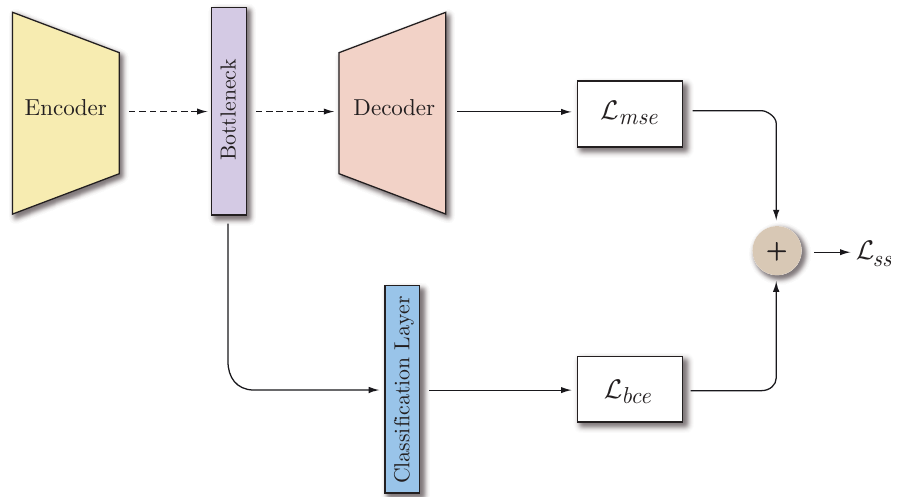
Figure 3. Semi-supervised autoencoder